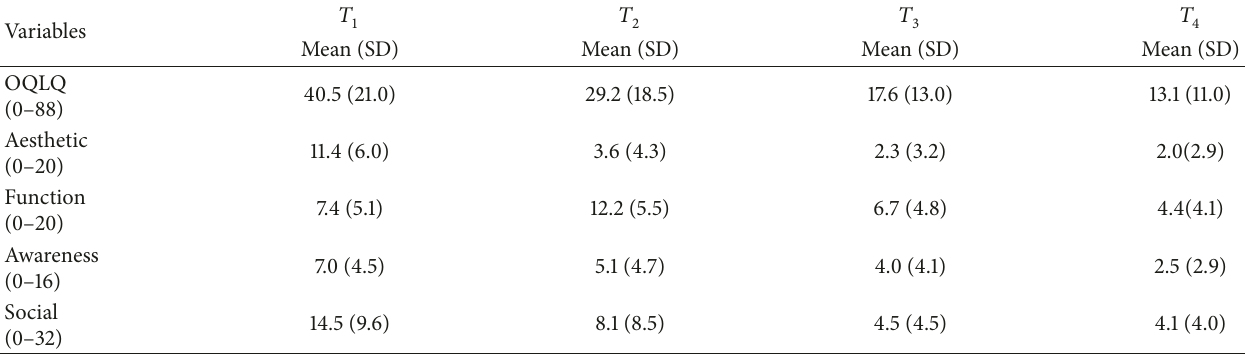
Table 2: Mean values of OQLQ and its subdomains scores in different stage of treatment.